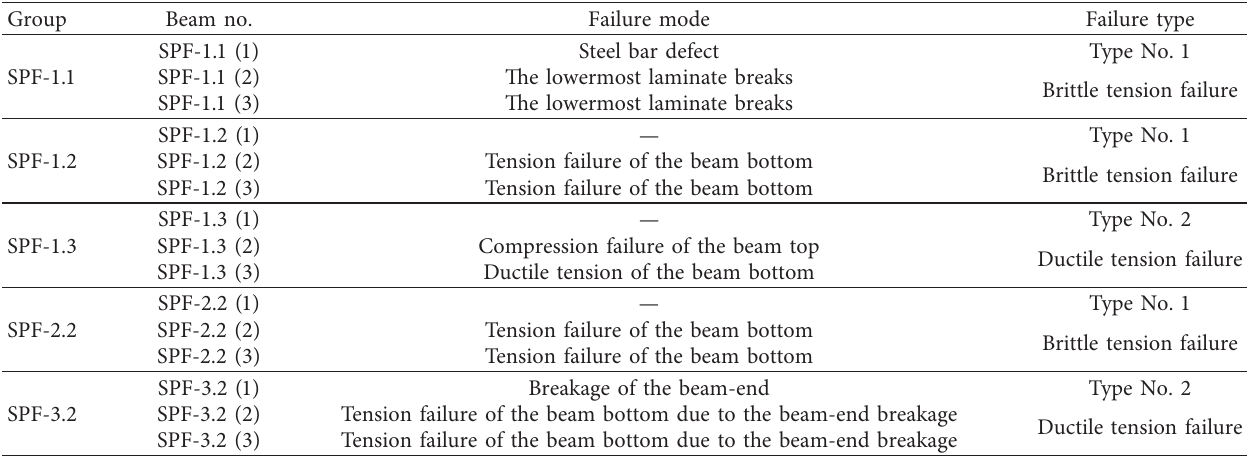
Table 3: Relationship between the failure modes of test beams and the corresponding failure types.